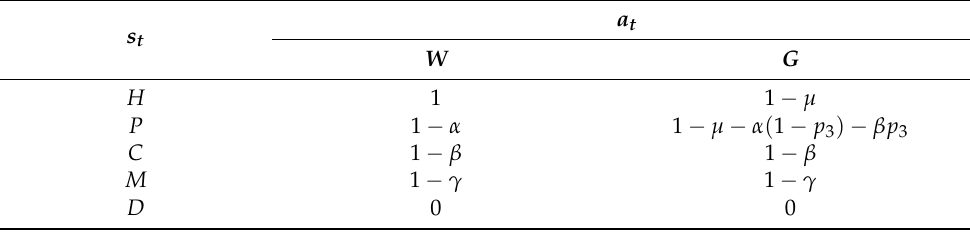
Table 1. Immediate